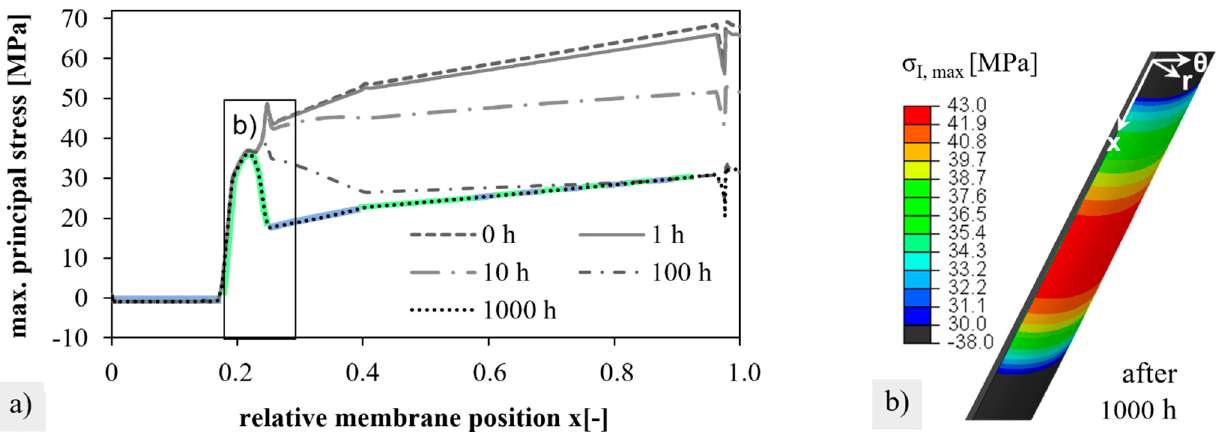
Figure 12. Maximum principal stress on the membrane outside after different creep times; ( a ) plotted versus the relative membrane length; radial (blue) and axial (green) stress components are marked. ( b ) Distribution around the stress maximum.